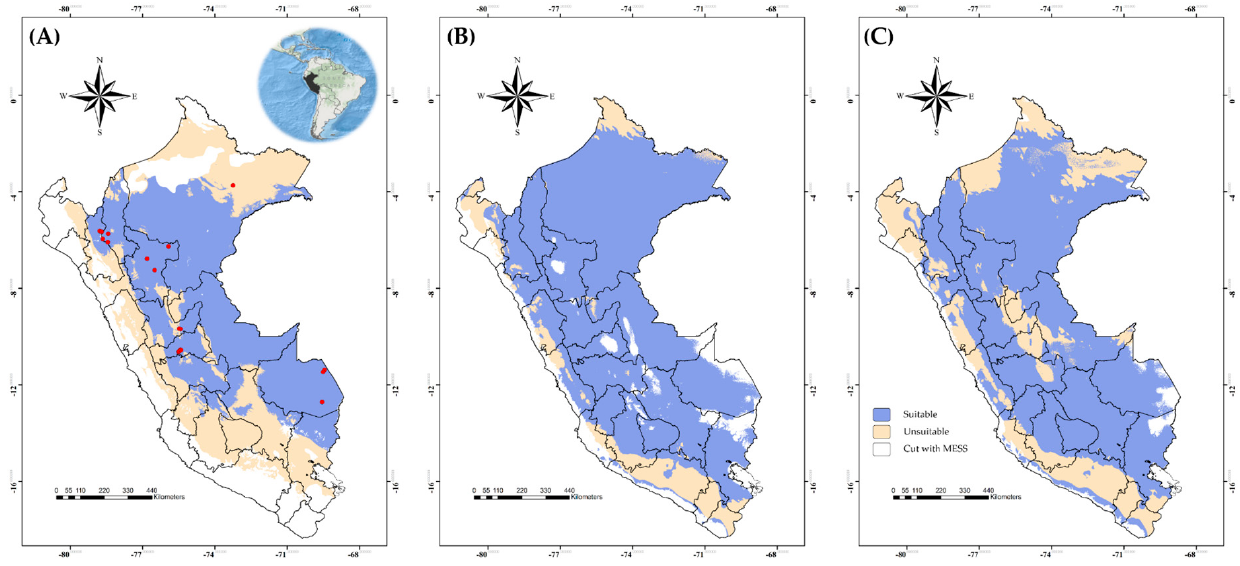
Figure 2. Suitable and unsuitable areas for the potential distribution of Culicoides insignis in Peru under ( A ) the current climate scenario, and ( B ) the climate change in 2071–2100 in the future climate scenarios of SSP126 and ( C ) SSP585. Occurrence records (red points).